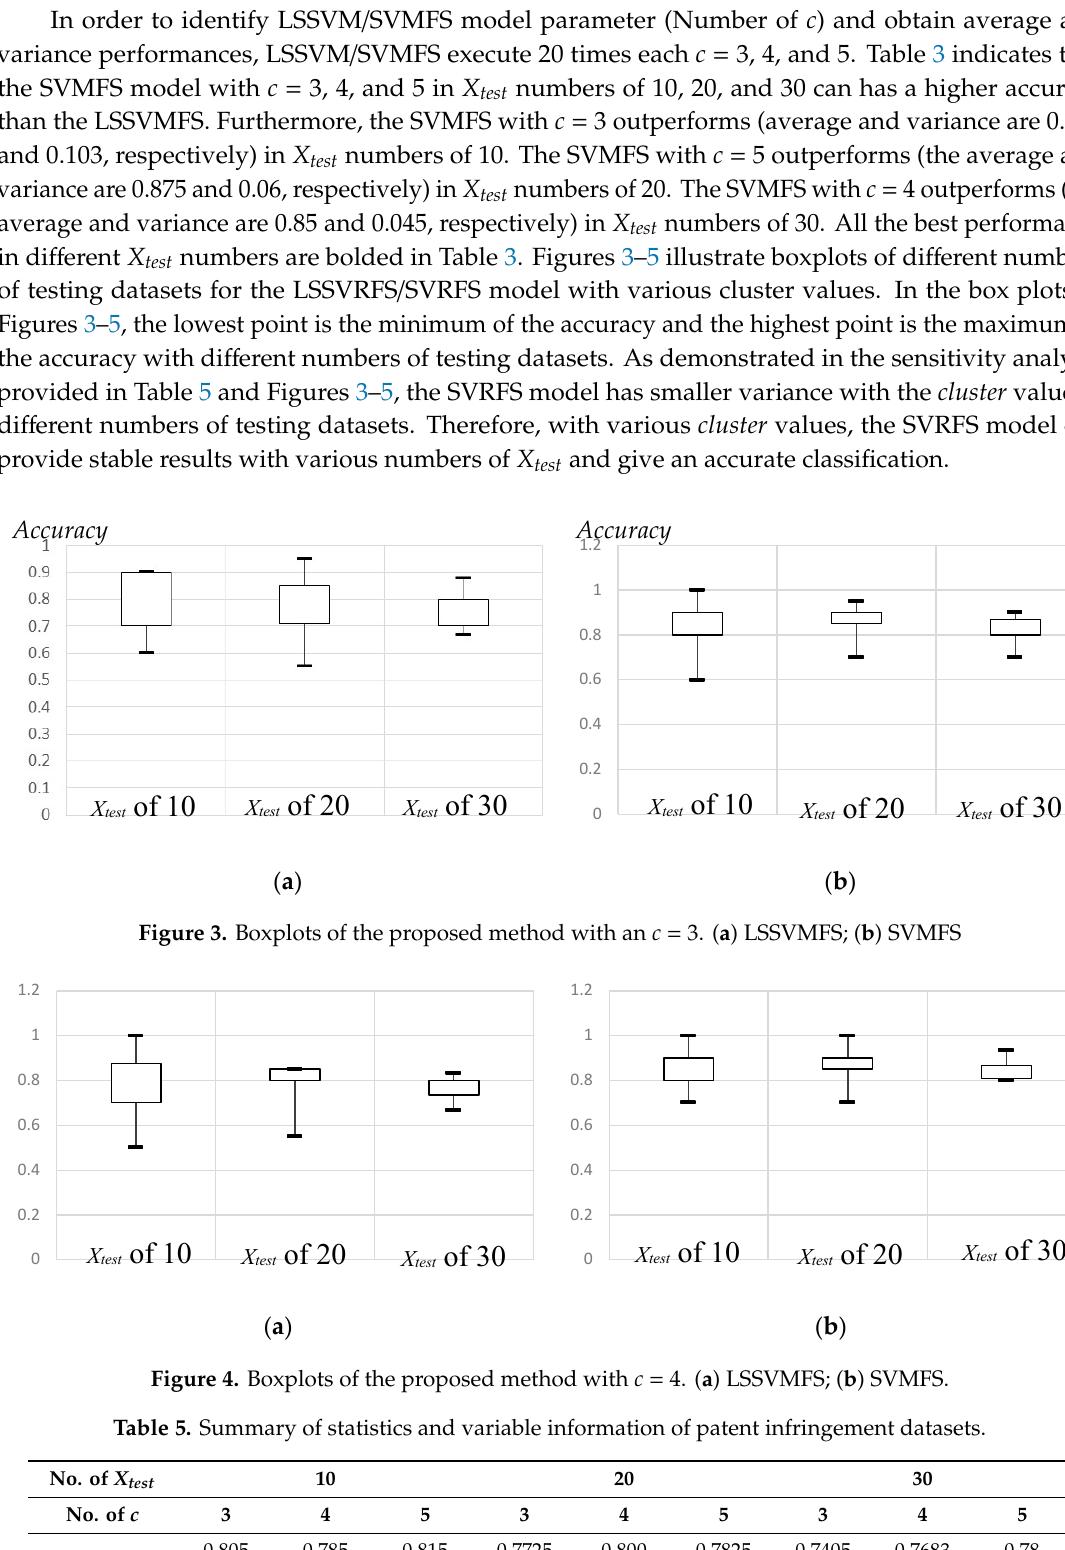
Table 5. Summary of statistics and variable information of patent infringement datasets.